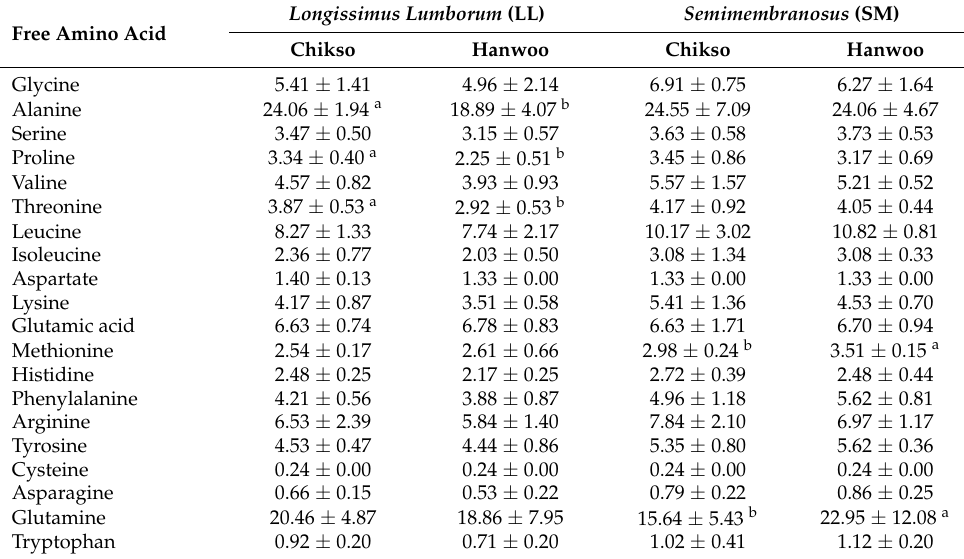
Table 3. Concentration (mg/100 g) of free amino acid in the LL and SM muscles from Chikso and Hanwoo under identical rearing